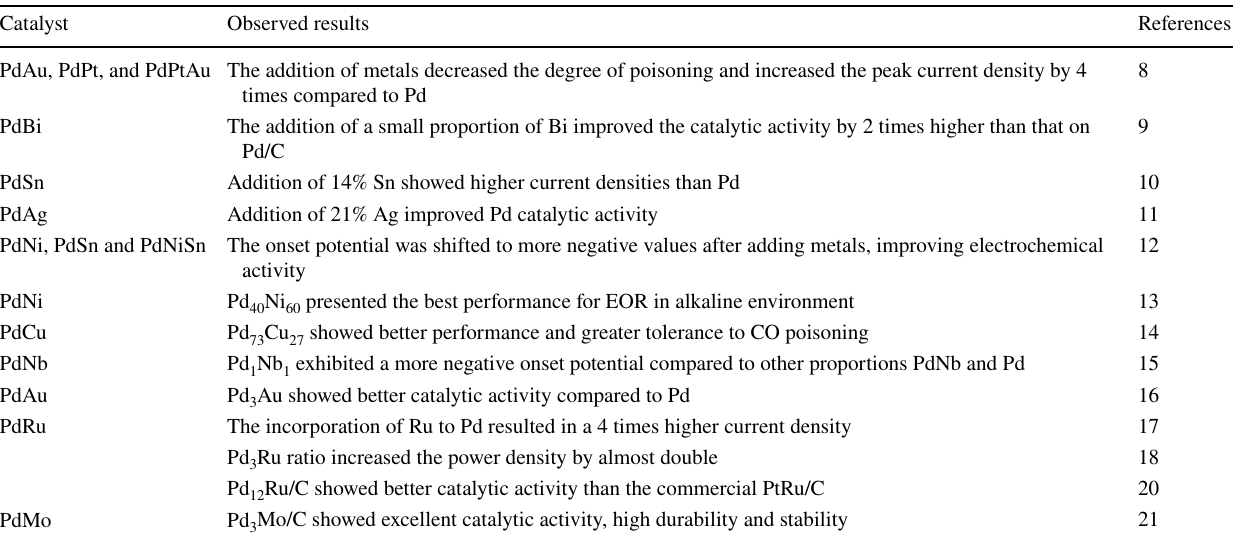
Table 1 Summary of the main Pd-based catalysts for EOR Catalyst Observed